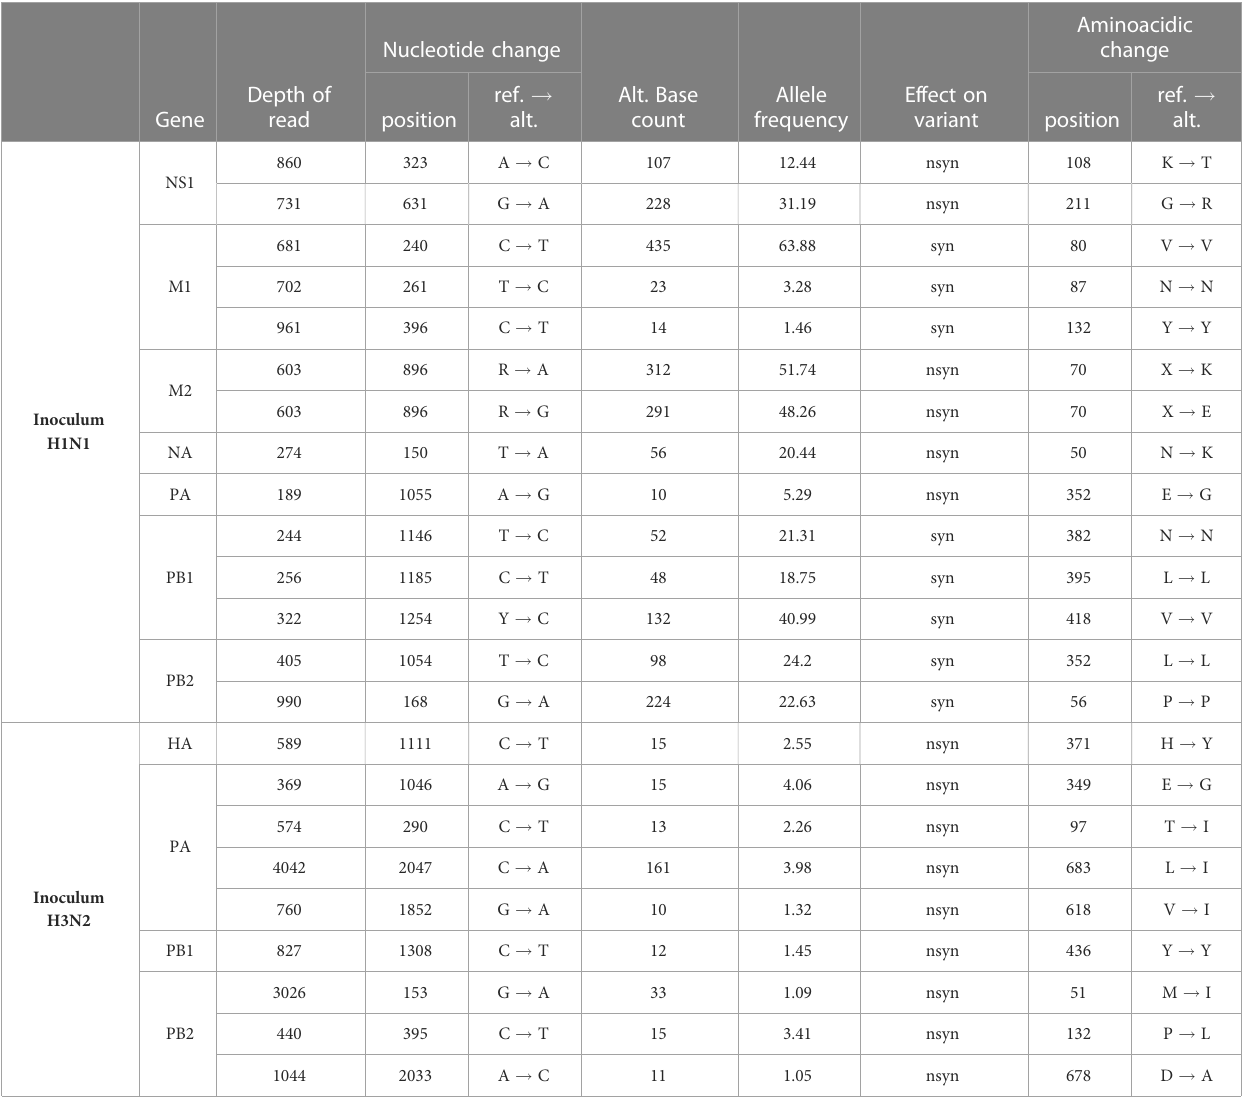
TABLE 3 SNV detected in H1N1 and H3N2 inoculum samples.